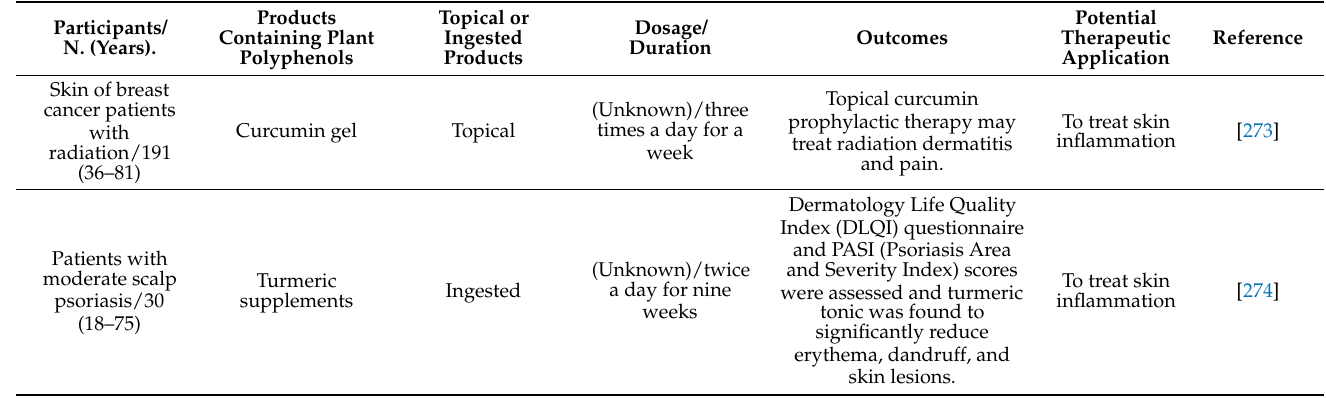
Table 4. Human clinical trials of plant polyphenols for oxidative stress-induced skin cellular senes- cence and